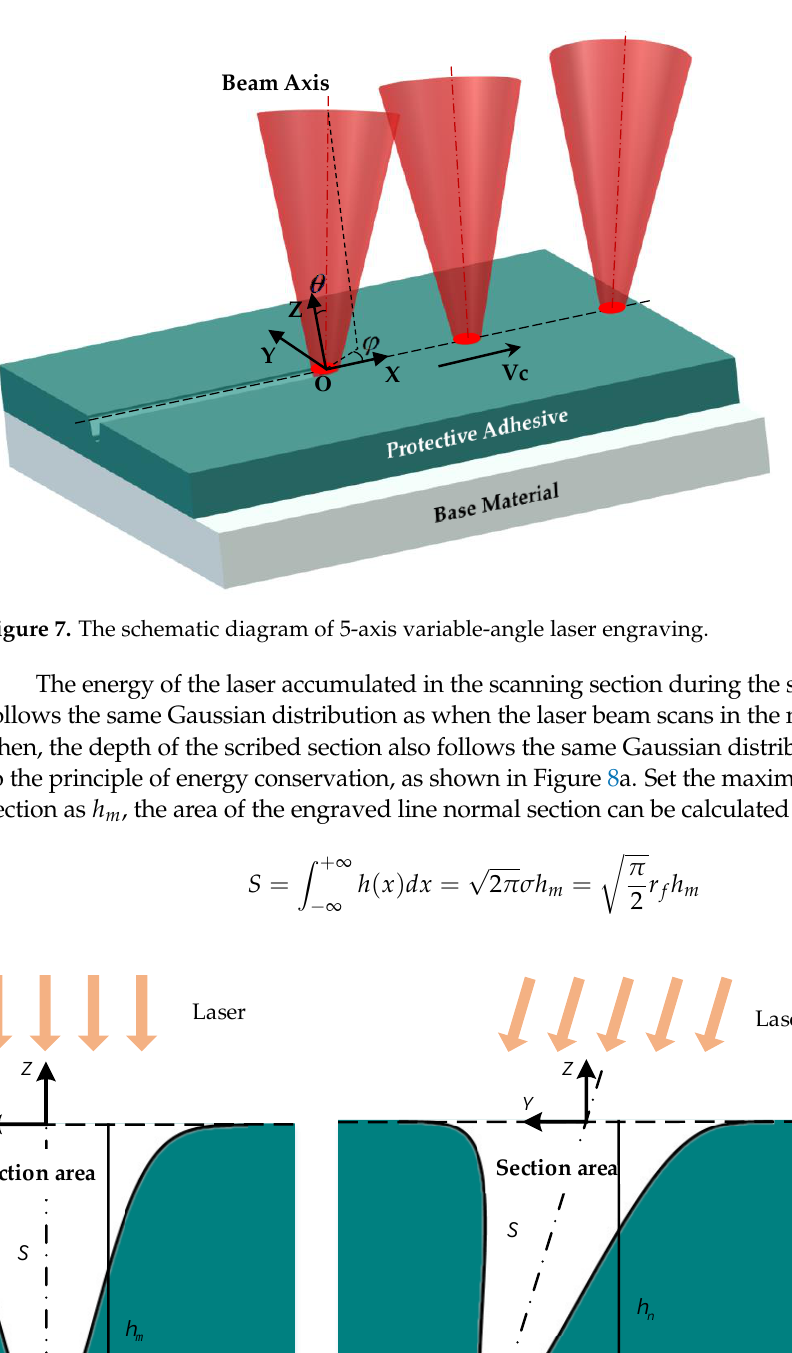
Figure 8. Section profile shapes of 5-axis variable-angle laser engraving. ( a ) Laser scanning normally to the surface; ( b ) laser scanning obliquely to the surface.